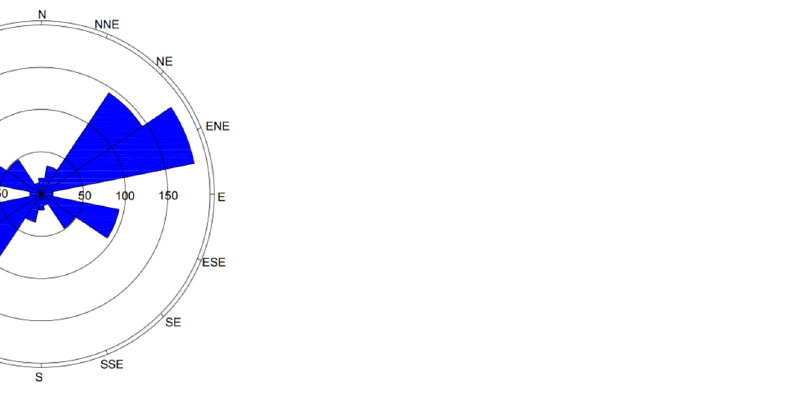
Figure 15. Rose map of linear geological formations. (The letters in the diagram indicate the orientation).